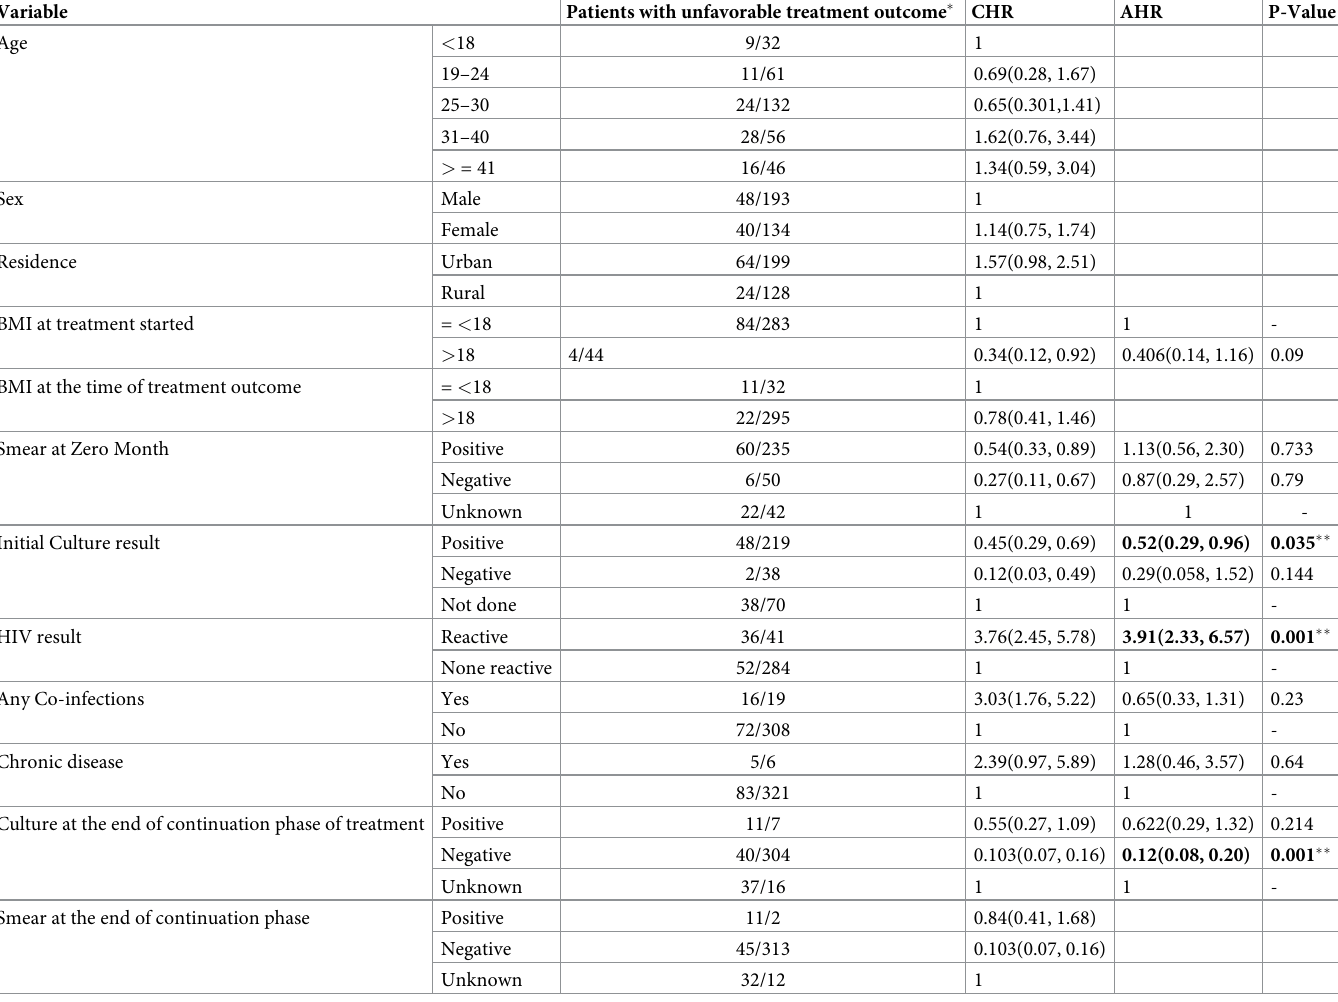
Table 3. Bivariate and multivariate Cox Proportional Hazards regression analysis of predictors for time to unfavorable treatment outcome among 415 MDR-TB patients at Oromia hospitals, Oromia Ethiopia.